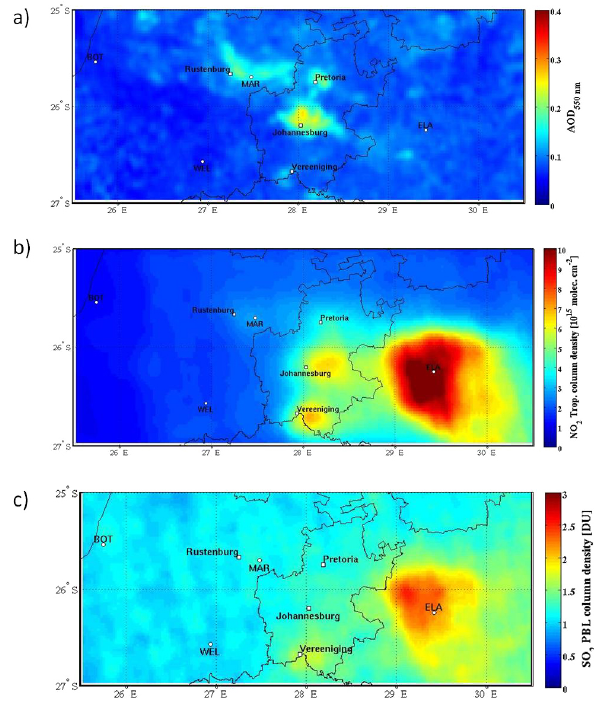
Figure 10. MODIS AOD (a) , OMI NO 2 (b) , and SO 2 (c) col- umn density medians for a 4-year period from January 2007 to December 2010. The locations of the in situ measurement sta- tions (ELA = Elandsfontein, MAR = Marikana, BOT = Botsalano, and WEL = Welgegund) are marked with white